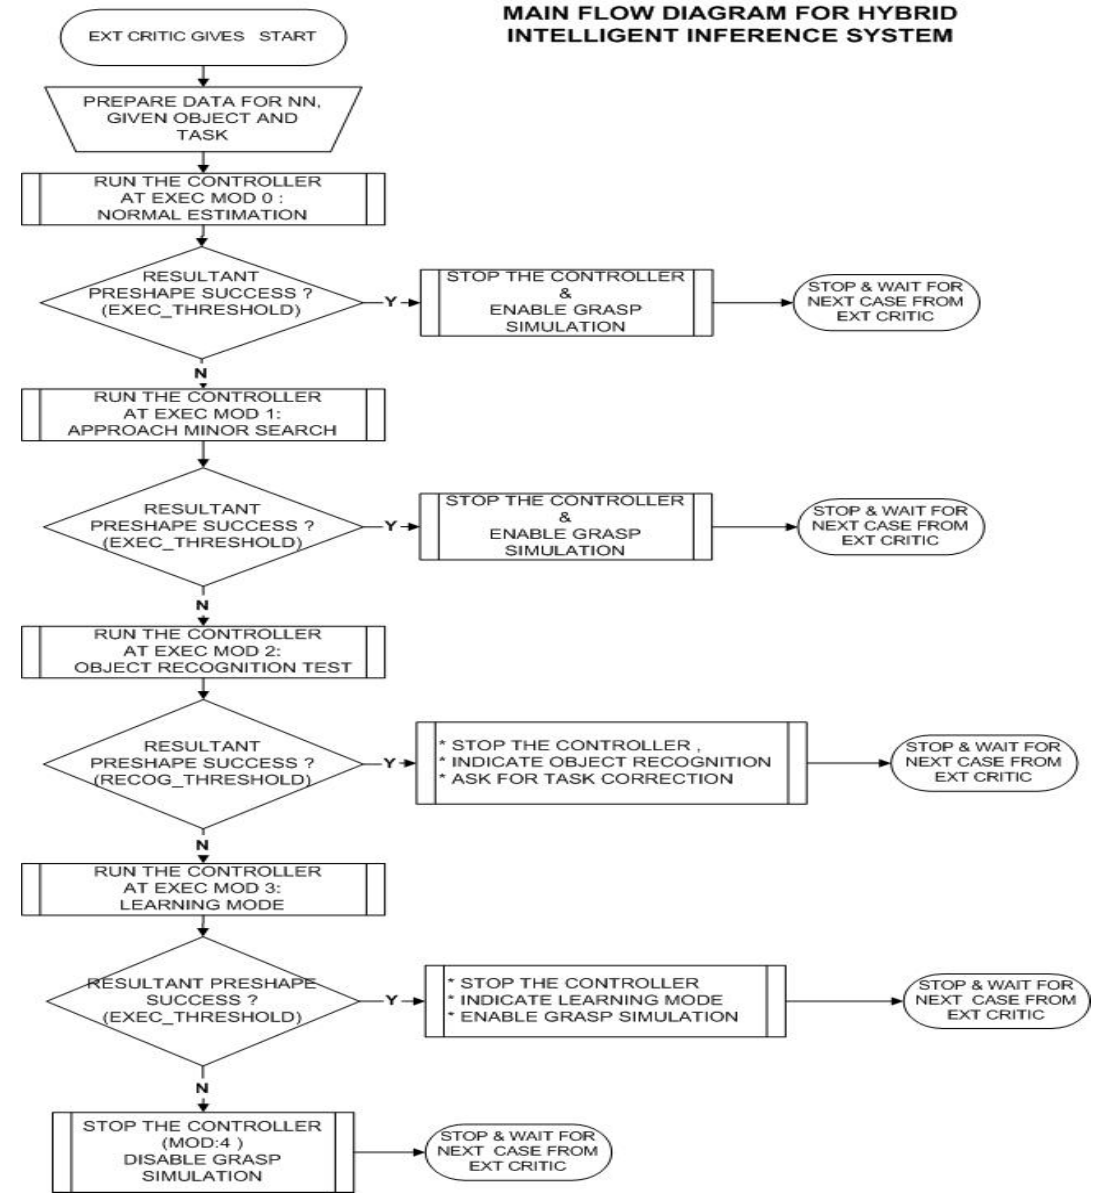
Figure 10. HIIS Execution Flow